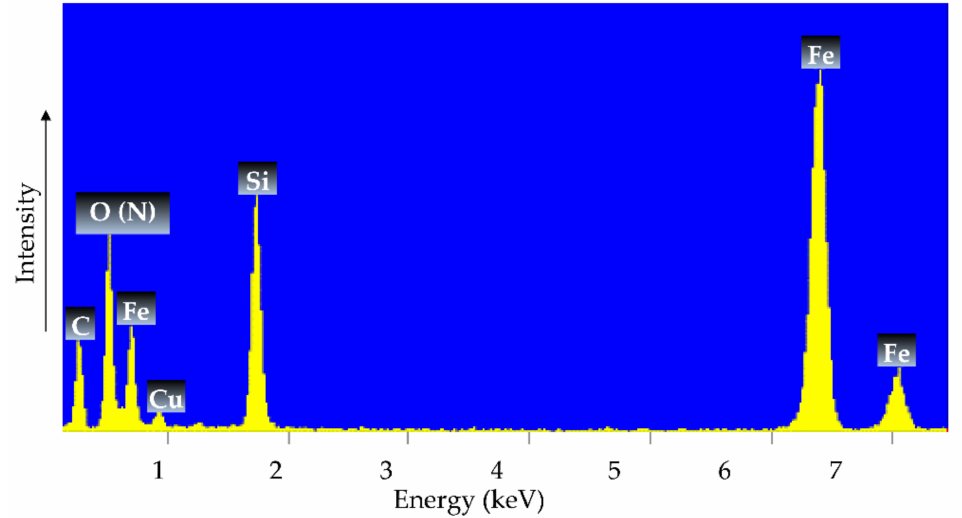
Figure 6. EDXS of the new, gradually synthesized γ -Fe 2 O 3 -(NH 4 OH)@SiO 2 (APTMS)